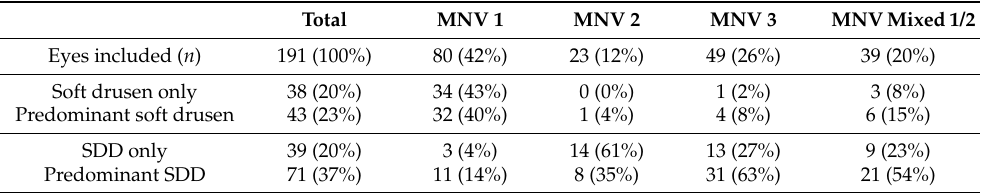
Table 2. Descriptive statistics of drusen types and MNV